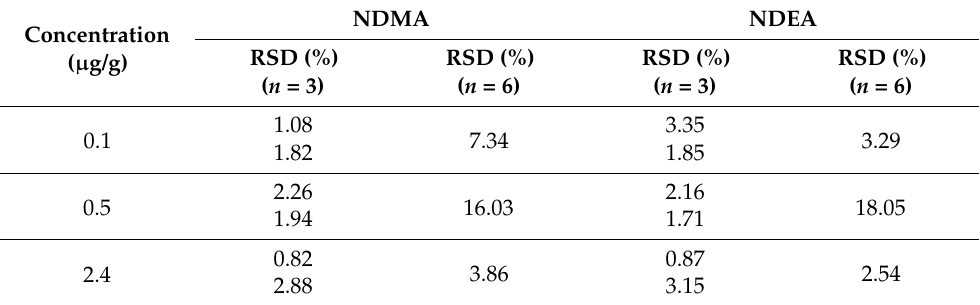
Table 3. Relative standard deviations obtained in the accuracy study.